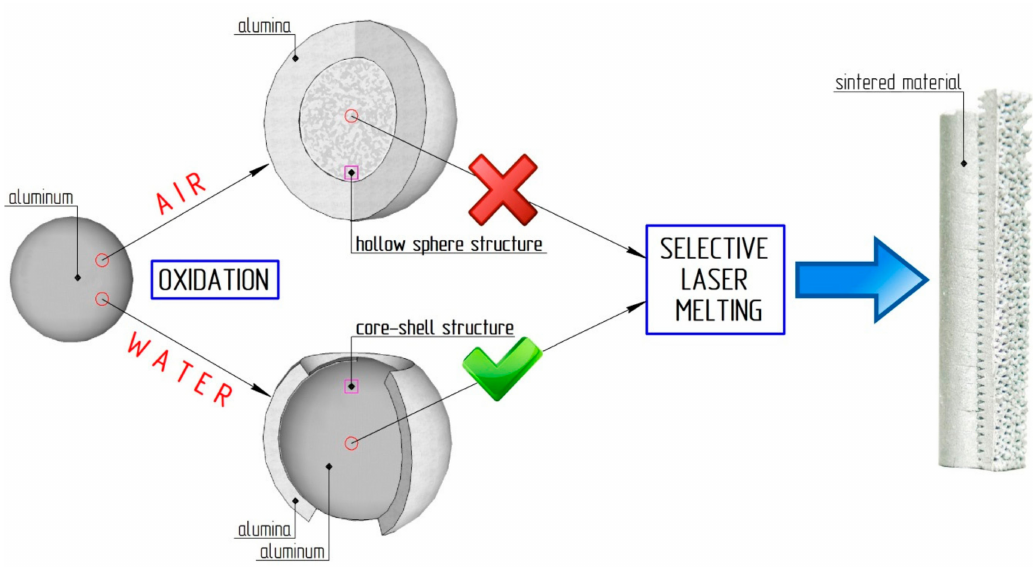
Figure 1. Scheme of the slow oxidation of aluminum particle by air and